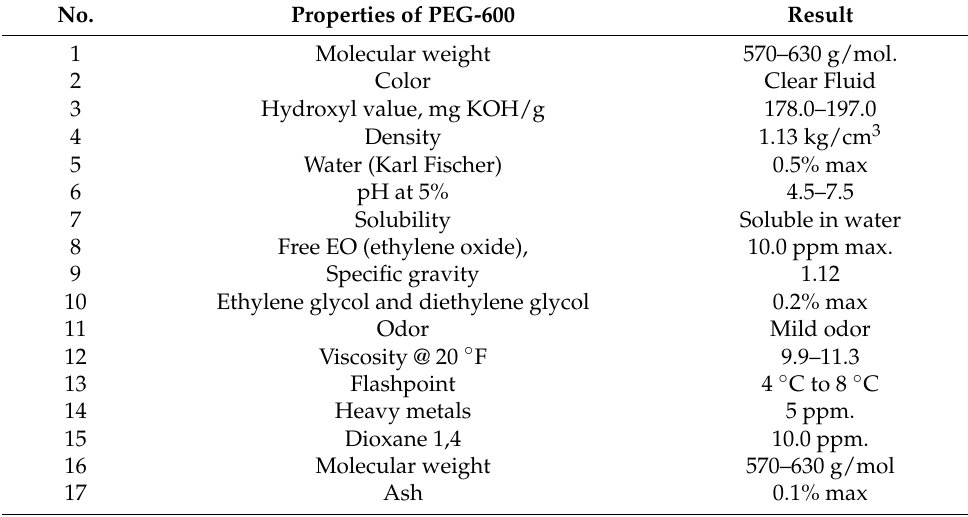
Table 3. Properties of polyethylene glycol